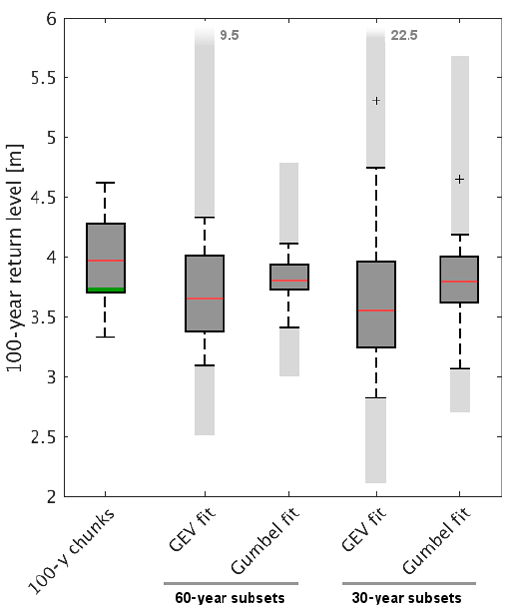
Figure 11. Box-and-whisker plots of RL 100 nonparametrically ob- tained from 10 × 100-year segments of the full simulation against RL 100 estimates based on GEV and Gumbel distributions fitted to 60- and 30-year subsets using maximum likelihood. The range of the dashed whiskers represents the total range of the fits and light grey shading represents the maximum range of the 95% confidence limits of the respective fits. The red lines indicate the median of the realizations, the green lines mark the RL 100 directly inferred from the full 1000-year-long